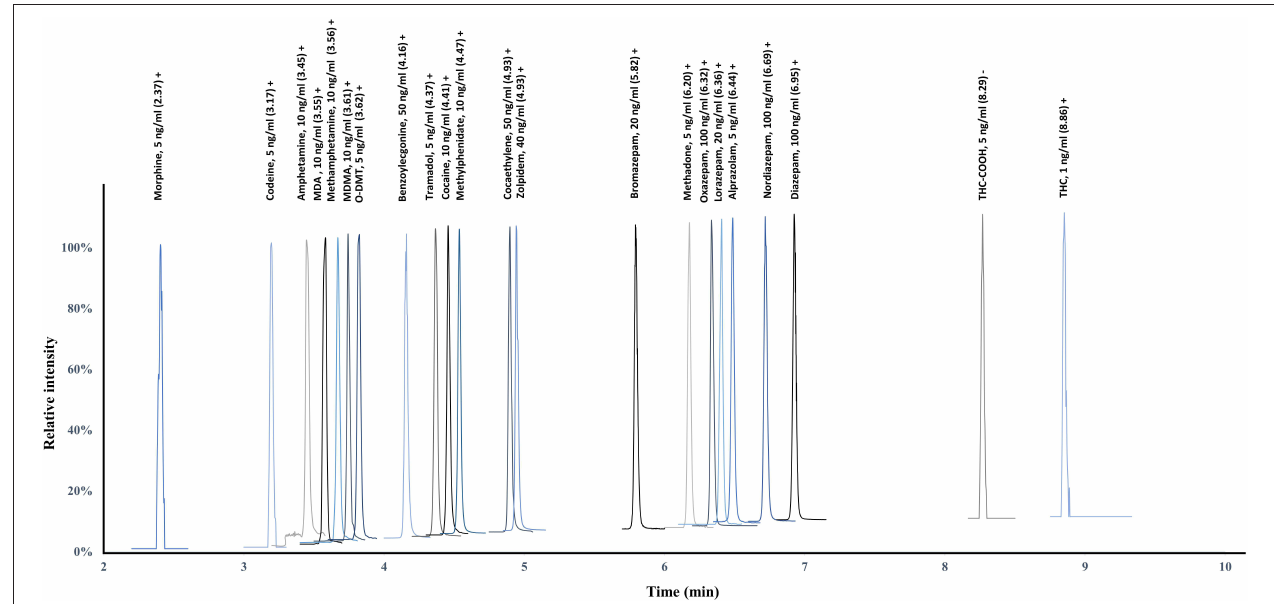
FIGURE 1 | Chromatographic separation at LOQ (calibration level 1) using retention time windows to ensure a sufficient number of acquisition points for proper quantification.